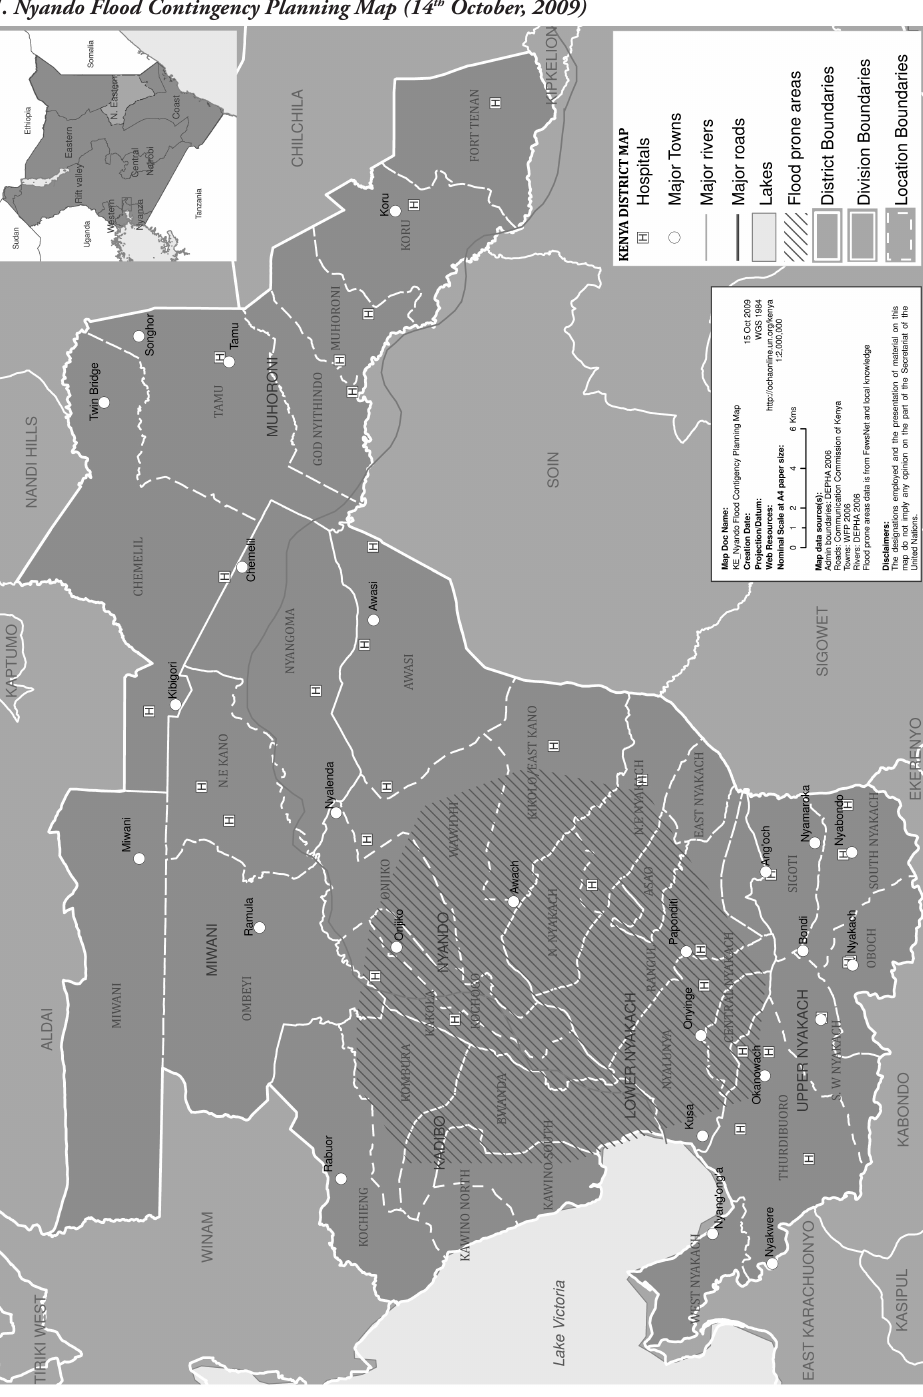
Fig 1. Nyando Flood Contingency Planning Map (14 th October, 2009)